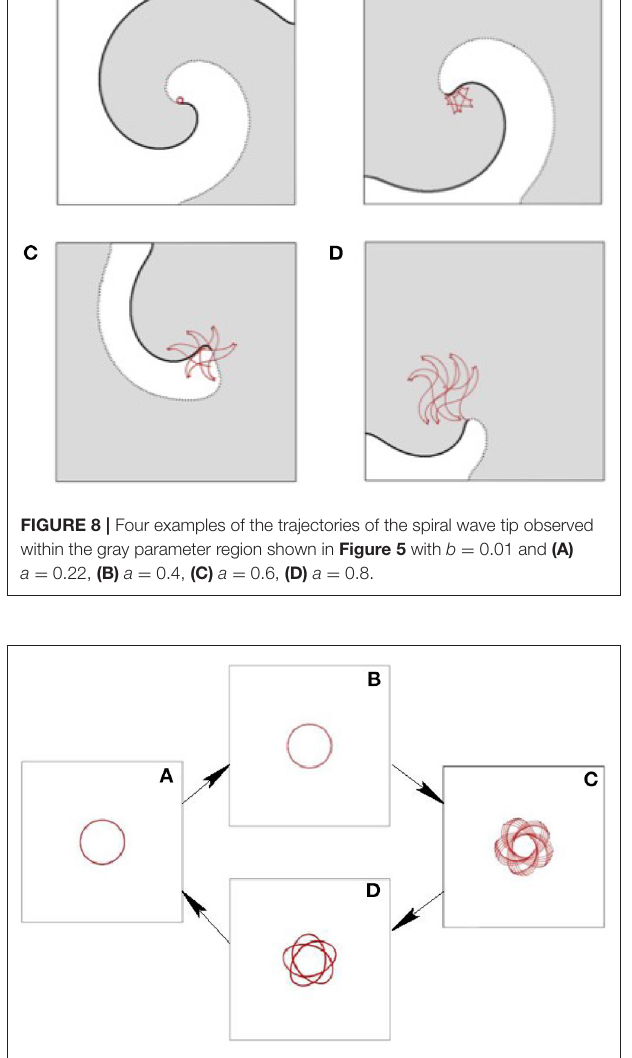
FIGURE 9 | The trajectories of the spiral wave tips obtained numerically for the modified Barkley model with the parameter b fixed as b = 0.015 and varied parameter a . (A) a = 0.31, (B) a = 0.32, (C) a = 0.325, (D) a =